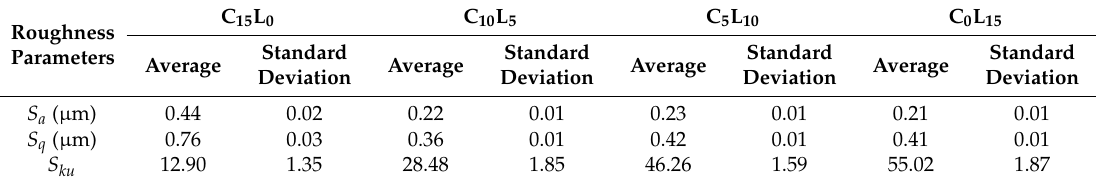
Figure 8. 3-D surface topography of the worn surfaces of the brake composites: ( a ) C 15 L 0 ; ( b ) C 10 L 5 ; ( c ) C 5 L 10 ; ( d ) C 0 L 15 . Table 8. Roughness parameter of the worn surface roughness of specimens.